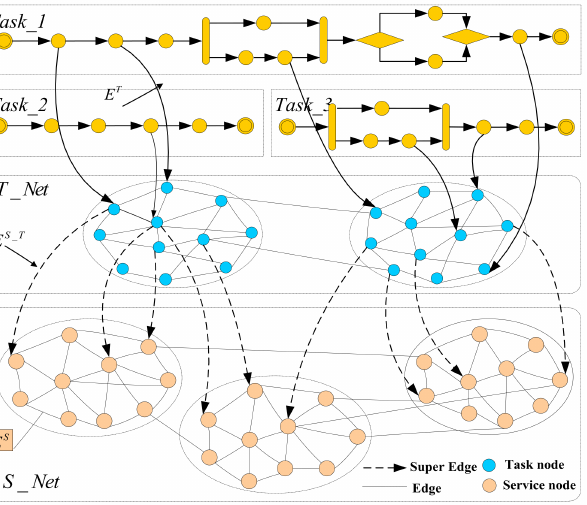
Figure 2. A flowchart of task-service network node matching, based on a Multi-Objective optimiza- tion